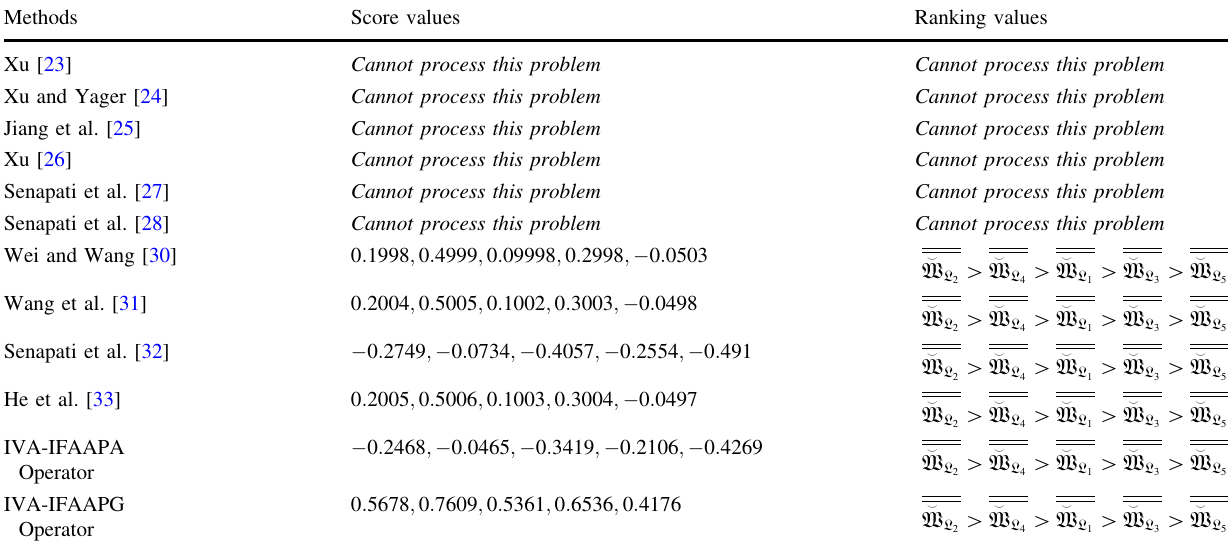
Table 9 Comparative results for the different operators Methods Score values